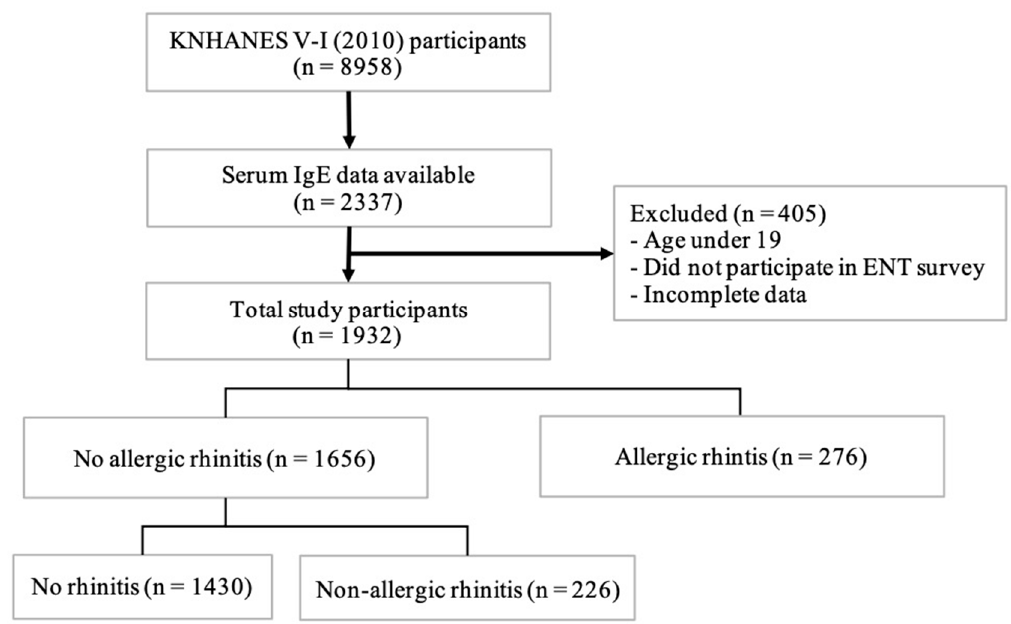
Figure1. Flowchartusedforparticipantselection. KNHANES,KoreaHealthandNutritionExamination Figure 1. Flowchart used for participant selection. KNHANES, Korea Health and Nutrition Survey; IgE, immunoglobulin E; ENT, Ear, Nose, and Examination Survey; IgE, immunoglobulin E; ENT, Ear, Nose, and Throat.